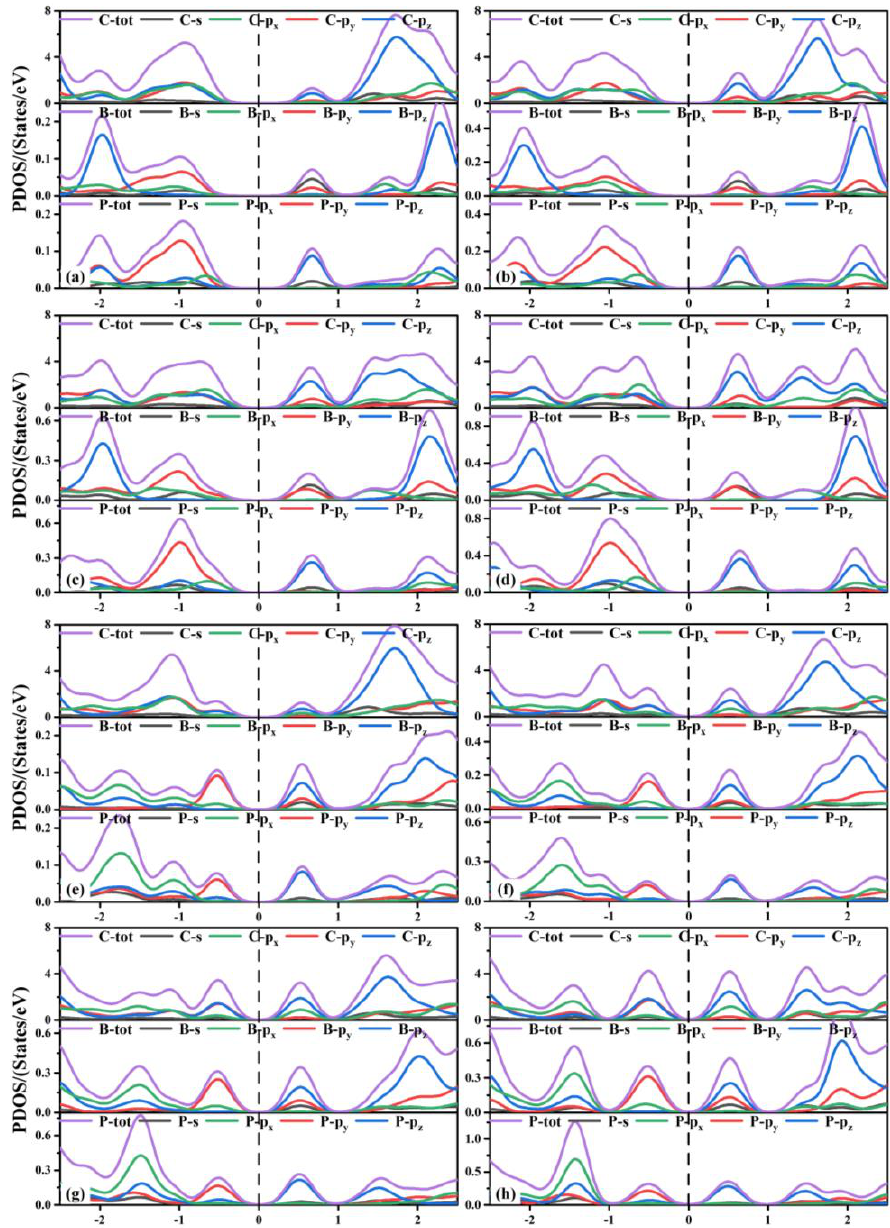
Figure 6. Partial density of states (PDOS) of TTG/BP systems. ( a ) TTG/BP-para-4.2%; ( b ) TTG/BP- para-8.3%; ( c ) TTG/BP-para-12.5%; ( d ) TTG/BP-para-16.7%; ( e ) TTG/BP-ortho-4.2%; ( f ) TTG/BP- ortho-8.3%; ( g ) TTG/BP-ortho-12.5%; ( h ) TTG/BP-ortho-16.7%.